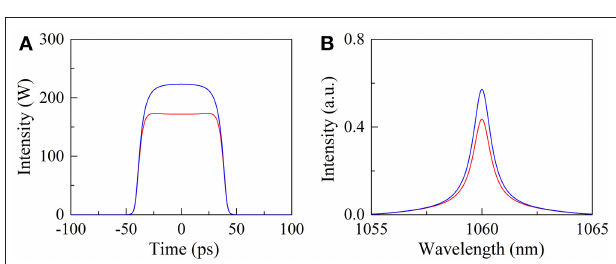
FIGURE 3 | Features of period-doubled DSR pulses. (A) The temporal profiles. (B) The corresponding pulse spectral